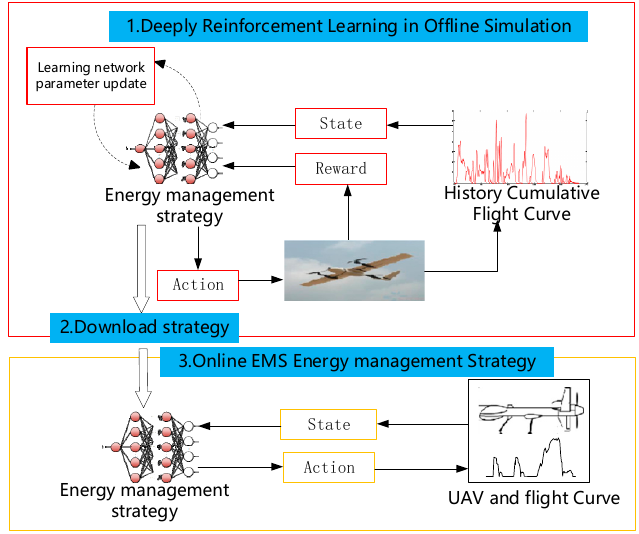
Figure 14. The overall schematic of DRL-based EMS for the UAV